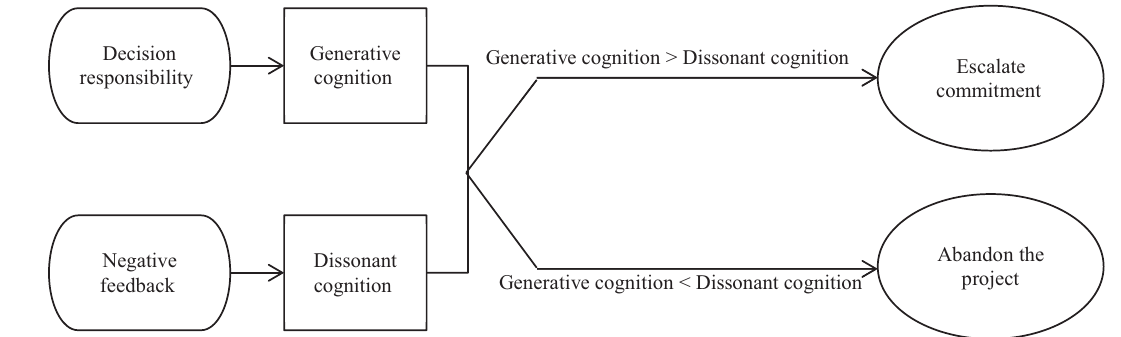
Figure 4. Relationship between generative cognition, dissonant cognition and